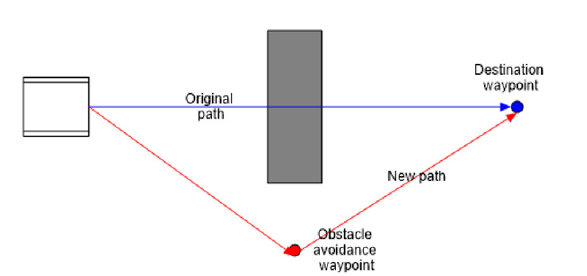
Figure 3. Obstacle avoidance algorithm